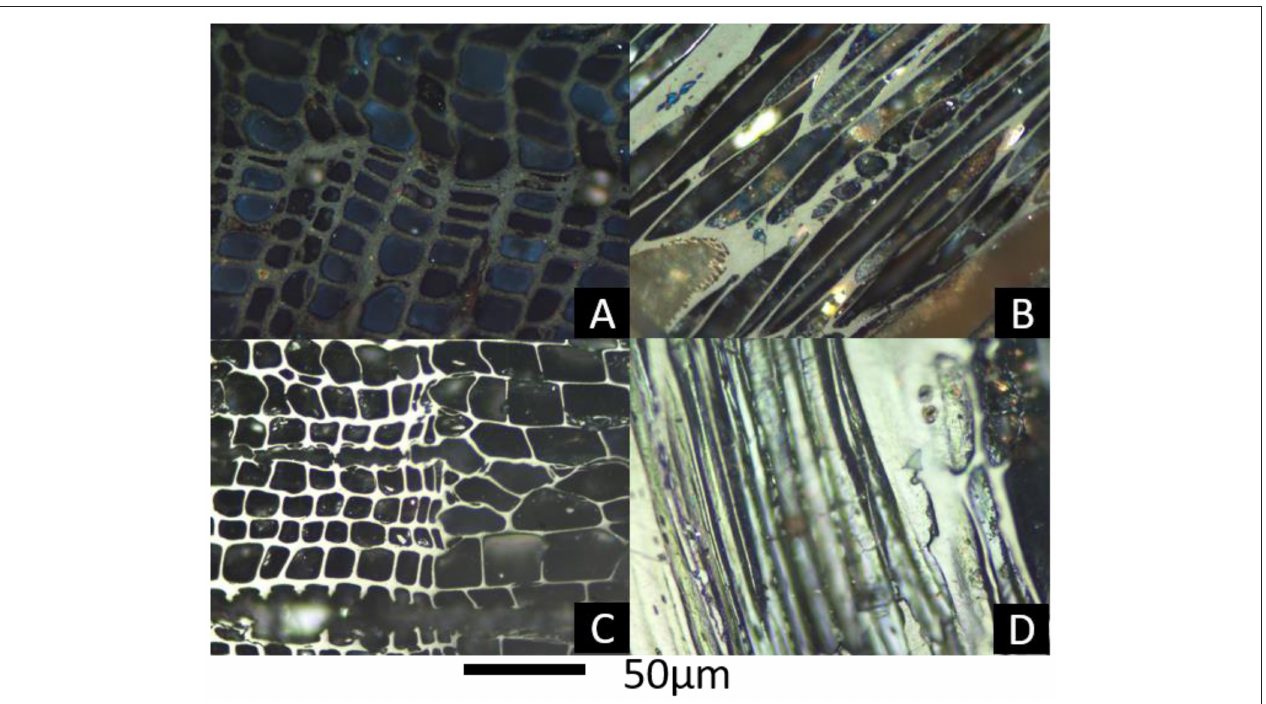
FIGURE 1 | Reflectance images, from polished blocks under oil, (A) AZ showing very low reflectance of conifer cell walls either side of a growth ring seen in transverse section; (B) TRAP Low reflectance of wood seen in longitudinal section, perforation plate at bottom left corner suggests angiosperm wood; (C) PC-N, anatomy as in A but high reflectance; (D) MA High reflectance of wood seen in longitudinal section, bordered pits at top right suggest gymnosperm.